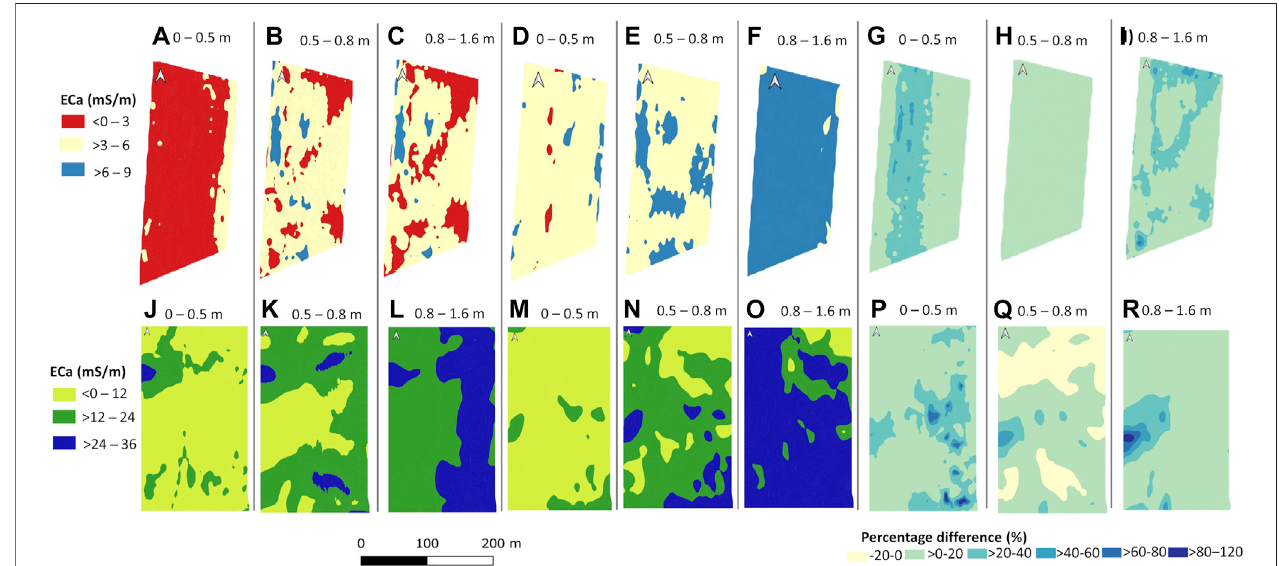
FIGURE2| Invertedelectricalconductivity(EC)atthreedepthsof0 – 0.5,0.5 – 0.8,and0.8 – 1.6 mattheMooribinsitetakenon7June2019[(dryseason — A – C )],on 19 August 2019 [(wet season — D – F )]. Percentage difference between the inverted EC of two surveys at three depths (G – I) . Similarly, at the Kukerin site on 4 June 2019